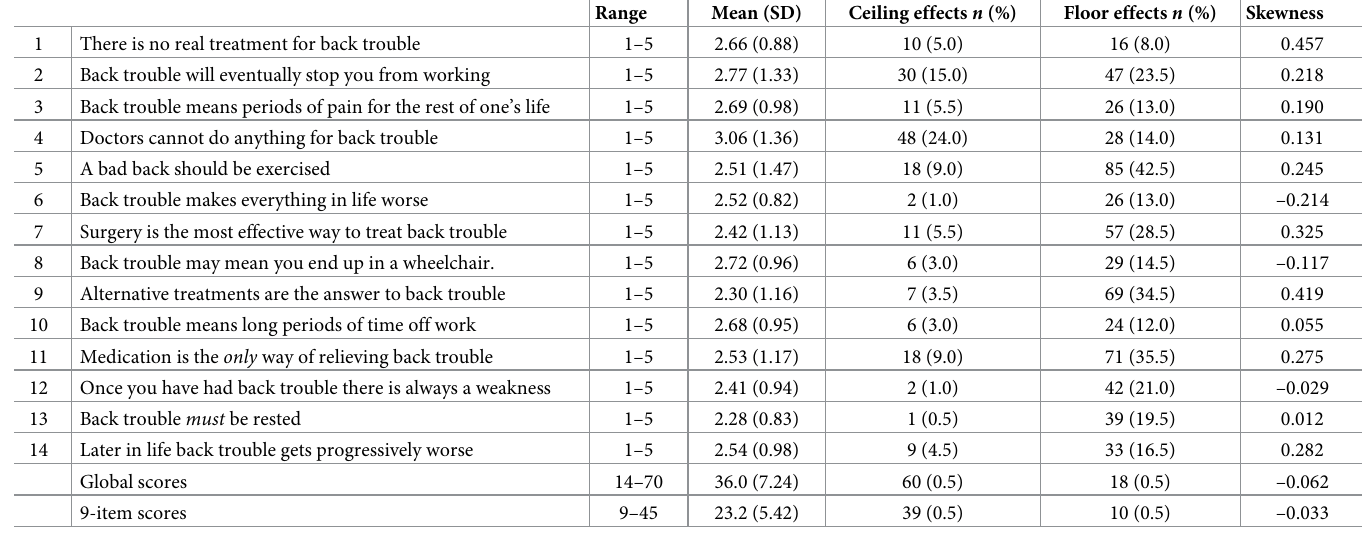
Table 2. General characteristics of the Hausa Back Beliefs Questionnaire (n = 200).